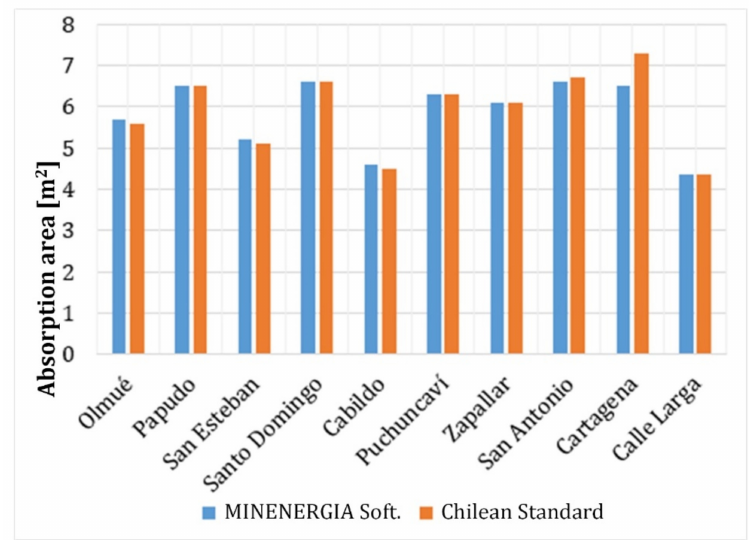
Figure 8. Comparison of two calculation methods for the value of absorption surface area in m 2 needed to cover 90% of demand in the most critical month.